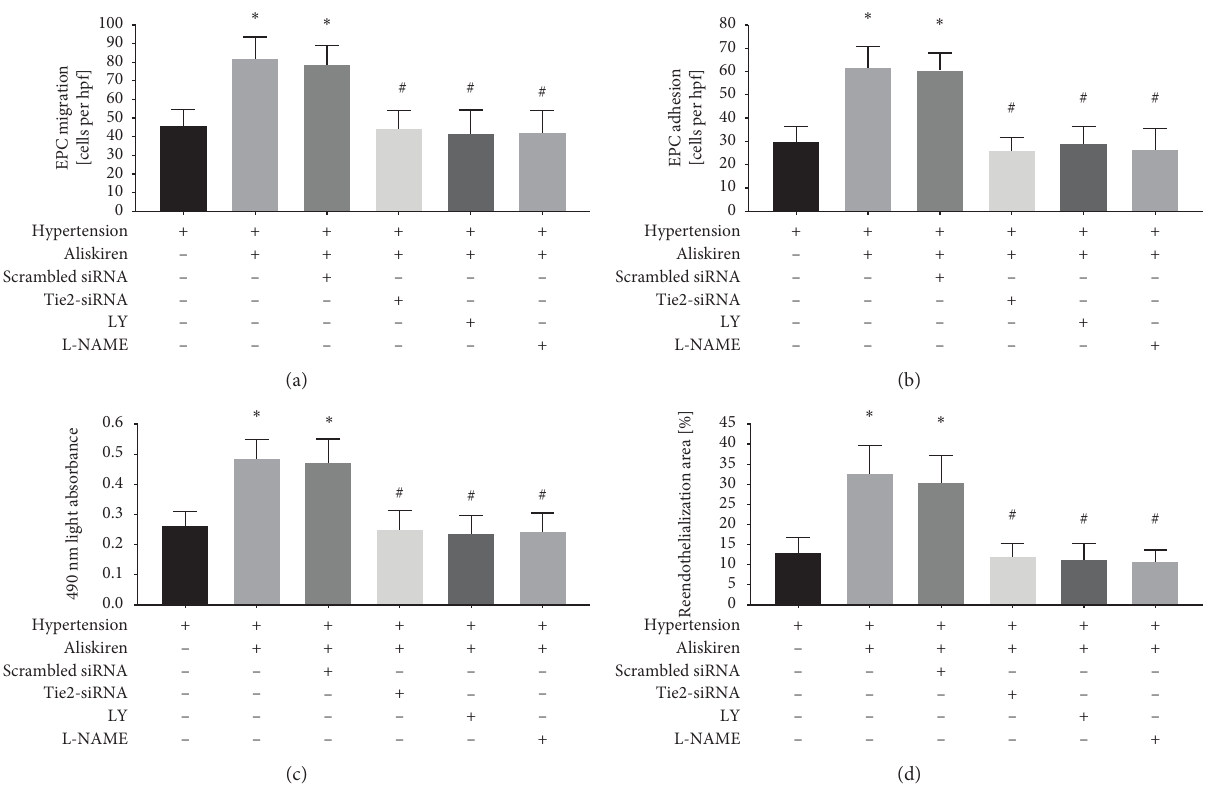
Figure 6: Tie2/PI3k/AKT signalling pathway blockade inhibits the in vitro function and in vivo reendothelialization capacity of EPCs treated with aliskiren. (a–c) Quantification analysis of aliskiren-mediated migration ( ∗ P < 0 . 05 vs. non-aliskiren-treated EPCs from normotensive subjects, n � 18 per group; # P < 0 . 05 vs. aliskiren-treated EPCs from hypertensive patients, n � 18 per group) (a), adhesion ( ∗ P < 0 . 05 vs. non-aliskiren-treated EPCs from normotensive subjects, n � 18 per group; # P < 0 . 05 vs. aliskiren-treated EPCs from hy- pertensive patients, n � 18 per group) (b), and proliferation ( ∗ P < 0 . 05 vs. non-aliskiren-treated EPCs from normotensive subjects, n � 18 per group; # P < 0 . 05 vs. aliskiren-treated EPCs from hypertensive patients, n � 18 per group) (c) of EPCs with Tie2 knockdown or after PI3k or eNOS inhibition. hpf � high-power field. (d) Quantification analysis of the aliskiren-mediated reendothelialization capacity of EPCs with Tie2 knockdown or after PI3k or eNOS inhibition ( ∗ P < 0 . 05 vs. non-aliskiren-treated EPCs from normotensive subjects, n � 18 per group; # P < 0 . 05 vs. aliskiren-treated EPCs from hypertensive patients, n � 18 per